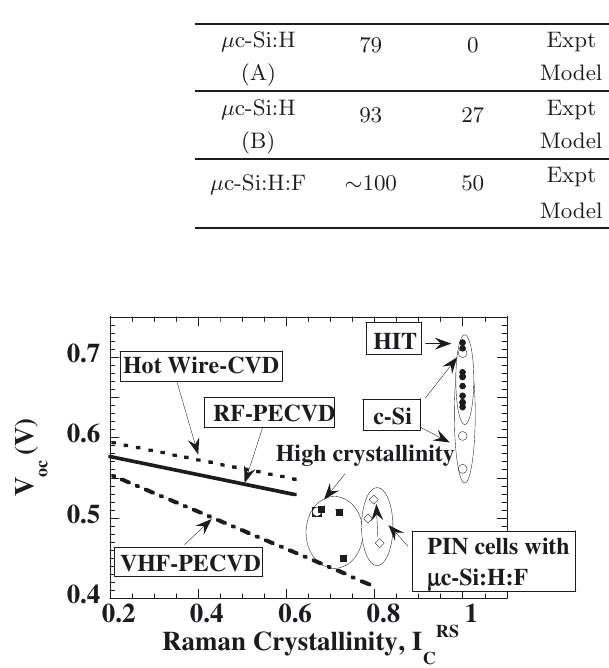
Fig. 1. Results taken from various literature sources [1–4] indi- cate the general trend of a decrease in the open-circuit voltage of μ c-Si:H thin film PIN cells, with increase of the Raman crys- tallinity of the films. We also show an exception where the V oc actually increases [5] in a highly crystallized μ c-Si:H:F cell, specially after interface treatment (indicated by the arrow). Also shown in the figure are typical V oc ’s of classical diffused junction c-Si solar cells (open circles – 5, Green’s ref), of a “het- erojunction with intrinsic thin layer (HIT)” cell on a P-type c-Si substrate [7] and of a HIT cell on N-type c-Si [8] (closed